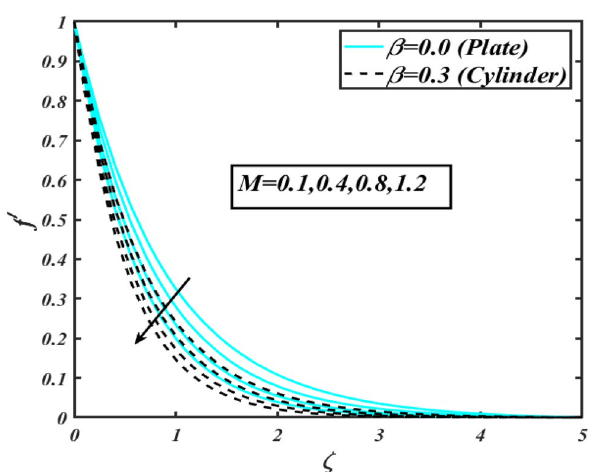
Figure 2. Profile of f ′ for M